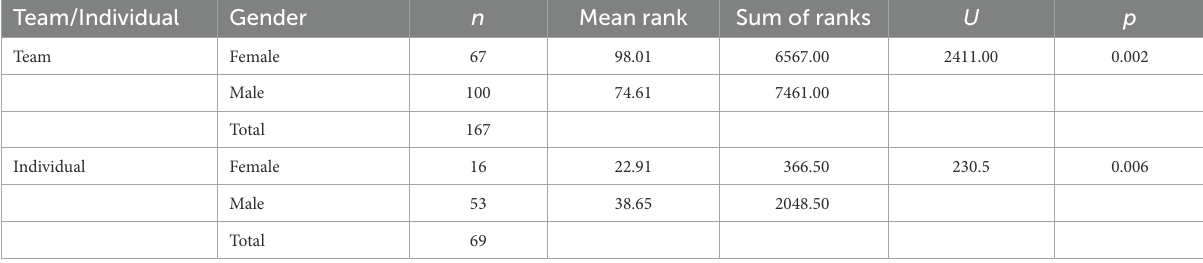
TABLE 5 Mann–Whitney U test results of the coach’s democratic behavior scores by